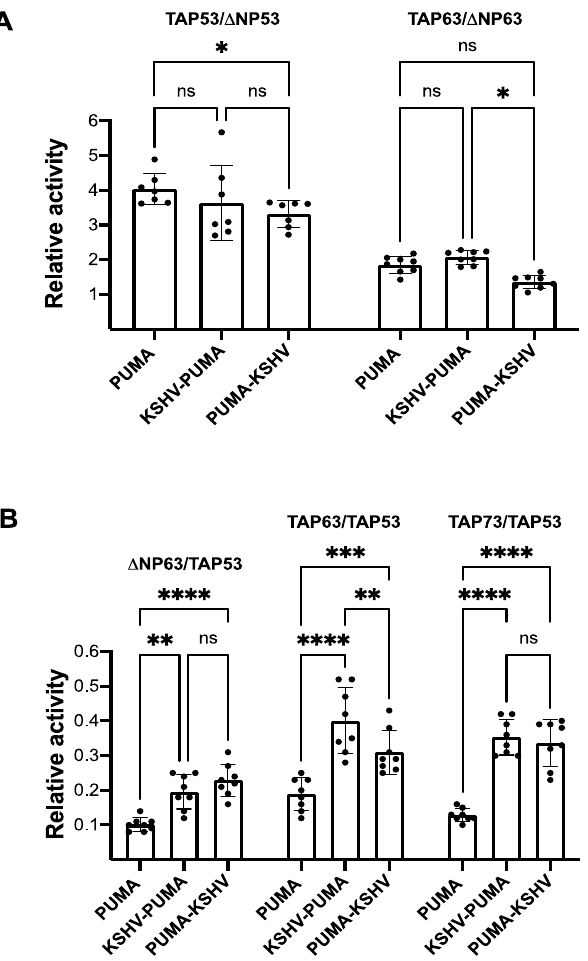
Figure 2. Relative activity of wild-type P53 family α isoforms. ( A ) Comparison of P53 (full-length P53) or P63 (TAP63 α ) TA variant activity with respect to the corresponding ∆ N variant ( ∆ N40P53 α and ∆ NP63 α , respectively) in yLFM-PUMA, yLFM-KSHV-PUMA, and yLFM-PUMA-KSHV strains. ( B ) Comparison of Δ NP63 α , TAP63 α , or TAP73 α variant activity with respect to TAP53 (full-length P53) variant in yLFM-PUMA, yLFM-KSHV-PUMA, and yLFM-PUMA-KSHV strains. ns: not significant, * p < 0.05; ** p < 0.01; *** p < 0.001; **** p < 0.0001.